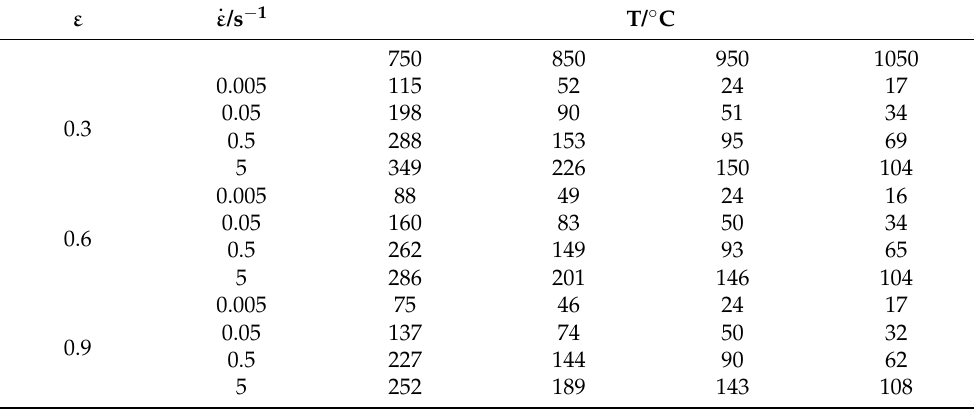
Table 1. Flow stresses of Ti555211 sample on various deformation conditions